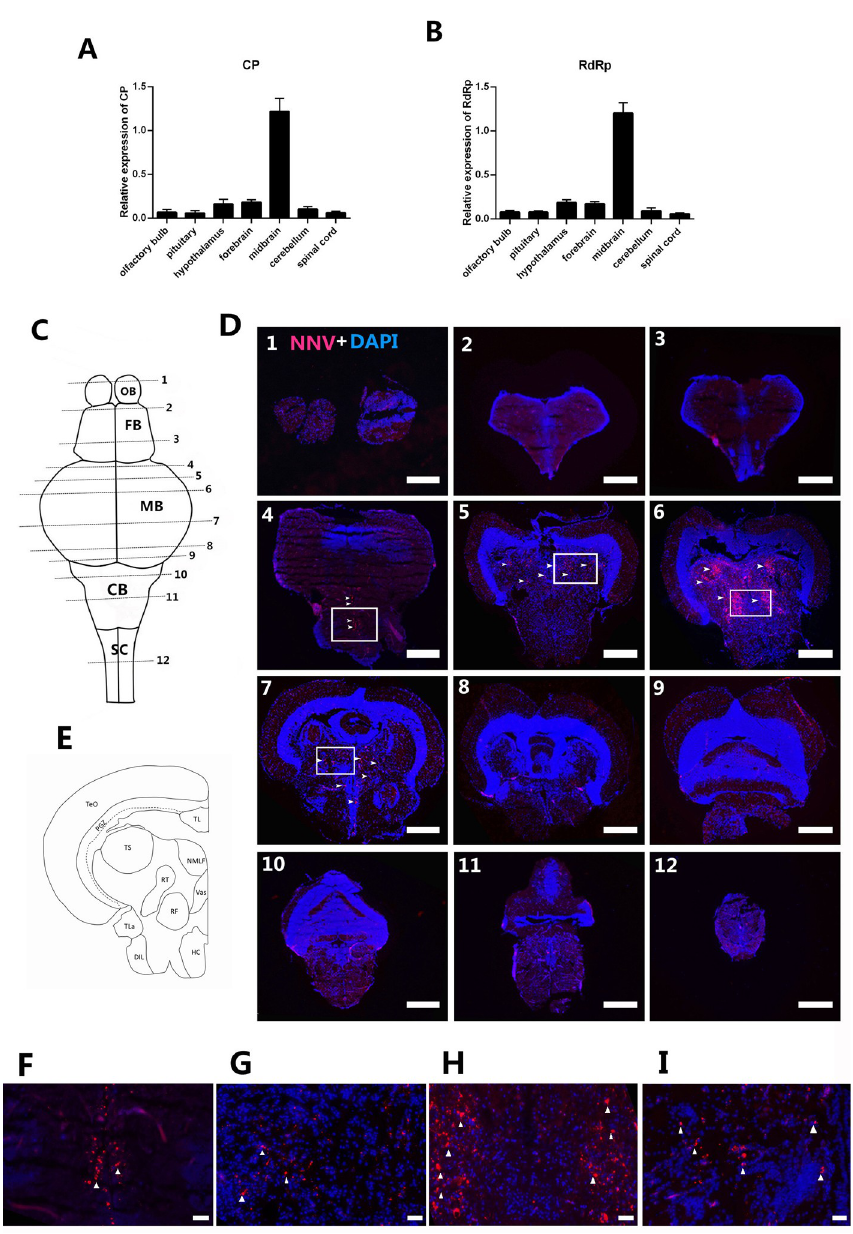
Fig 1. The main attack site of RGNNV in the grouper brain tissue. After infection with RGNNV, the relative quantities (compared to β -actin) of viral genomic RNA of CP (A) and RdRp (B) in different brain regions were examined using RT-qPCR (n = 5). (C) Dorsal view of the grouper brain; the horizontal line represents the slice position. (D) Localization of RGNNV as indicated by in situ hybridization. The NNV-positive signals were mainly found in midbrain (MB) regions, and the mainly replicated intercept of the MB was the position of slices 4, 5, 6, and 7. The most replicated areas were the torus semicircularis (TS), rostral tegmental nucleus (RT), reticular formation (RF), nucleus of the medial longitudinal fascicle (NMLF), and vascular lacuna of area postrema (Vas). The white arrow indicates positive staining for a probe targeting the CP region of the RGGNV genome. (E) Schematic MB drawing of the grouper. (F–I) high magnification of the boxed areas in D 4–7. OB: olfactory bulb, FB: forebrain, CB: cerebellum, SC: spinal cord, TeO: tectum opticum, PGZ: periventricular gray zone of optic tectum, TL: torus longitudinalis, TLa: torus lateralis, DIL:diffuse nucleus of the inferior lobe, HC: caudal zone of periventricular hypothalamus. Scale bars of D, 400 μ m. Scale bars of F-I, 50 μ m.